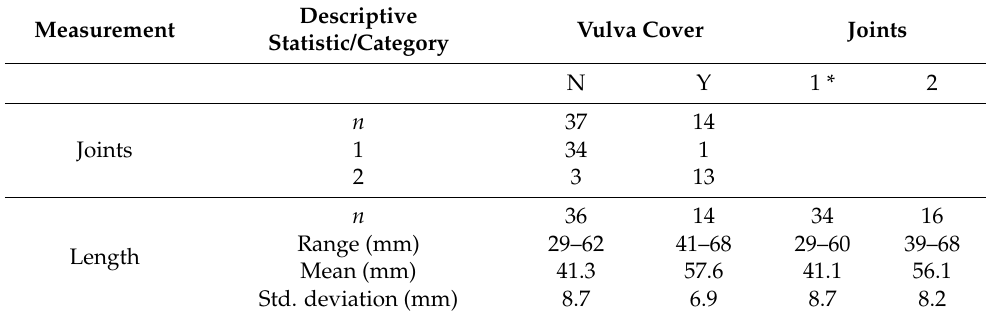
Table 4. Descriptive statistics of the measurement methods used to assess yearling